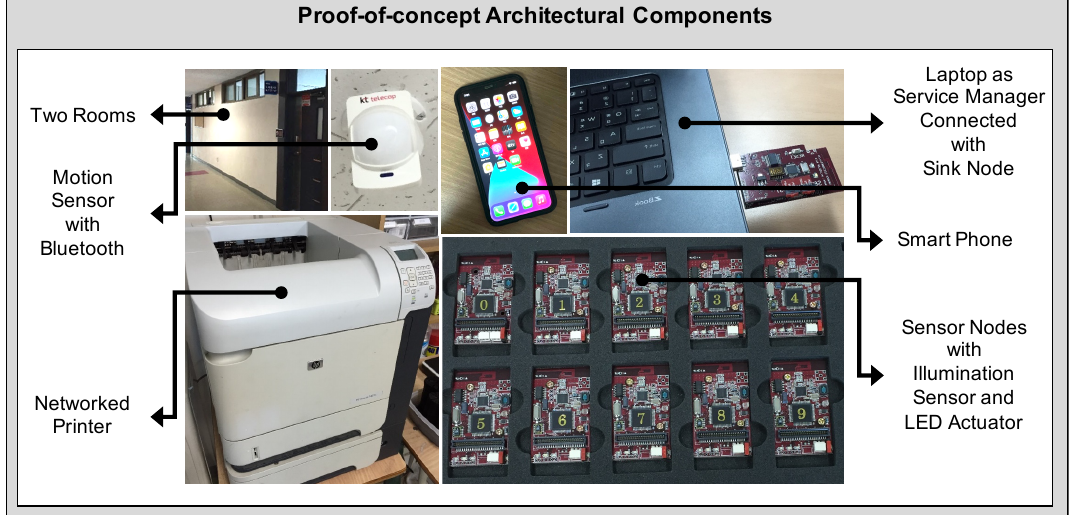
Figure 7. Smart office scenario with proximity abstraction and